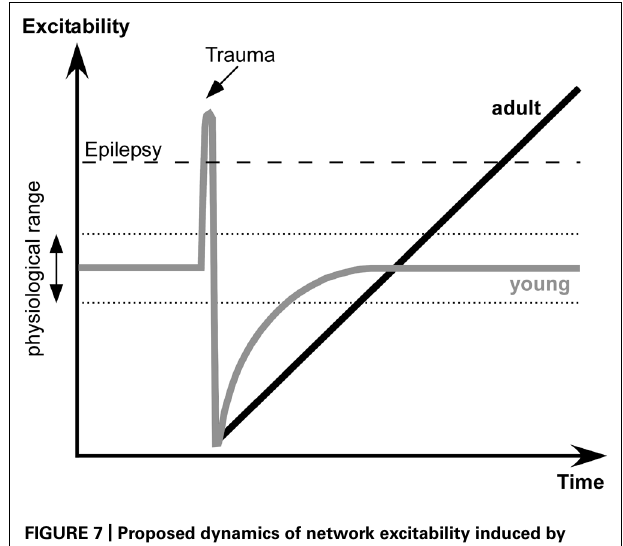
post seizure states of the brain is shown in the panel (D) . Panels (A–C,E) are segments expended in time as indicated in panel (D) . All abbreviations are as in Figure 4 .